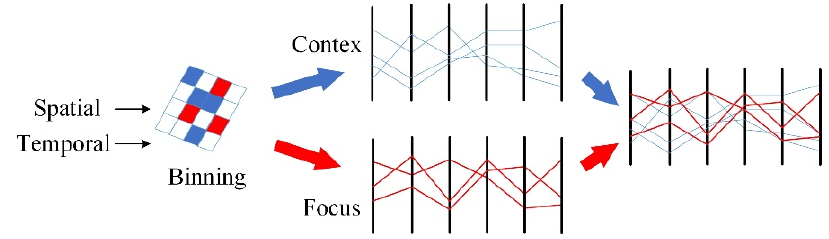
Figure 5. Parallel coordinate systems using the focus context.